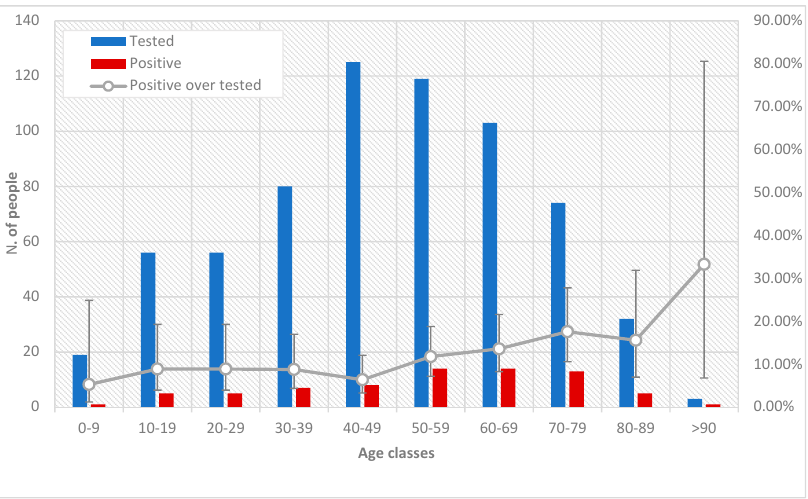
Figure 1. Individuals tested, and tested positive, for SARS-CoV-2 antibodies, stratified by age groups. The frequency of clinical symptoms experienced by individuals during the two months prior to sampling was recorded. The 25.9% (95% CI, 16.4%–38.4%) of symptomatic individuals tested positive, versus the 9.5% (95% CI, 7.4%–12.1%) of the asymptomatic. The difference between the seroprevalence of infection in asymptomatic and symptomatic individuals was significant ( χ 2 = 14.50